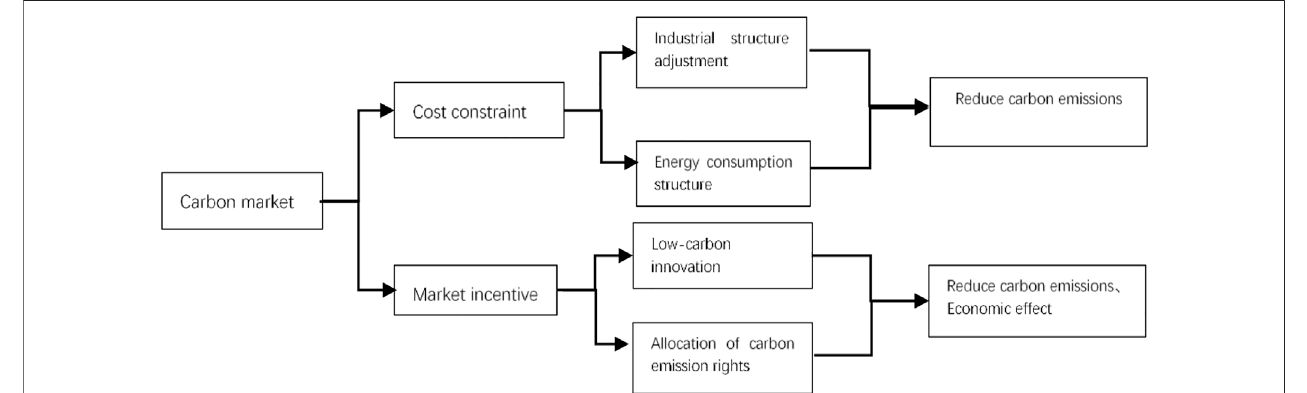
FIGURE 5 | Carbon market mechanism.